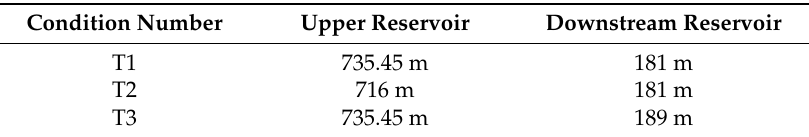
Table 14. Working conditions.